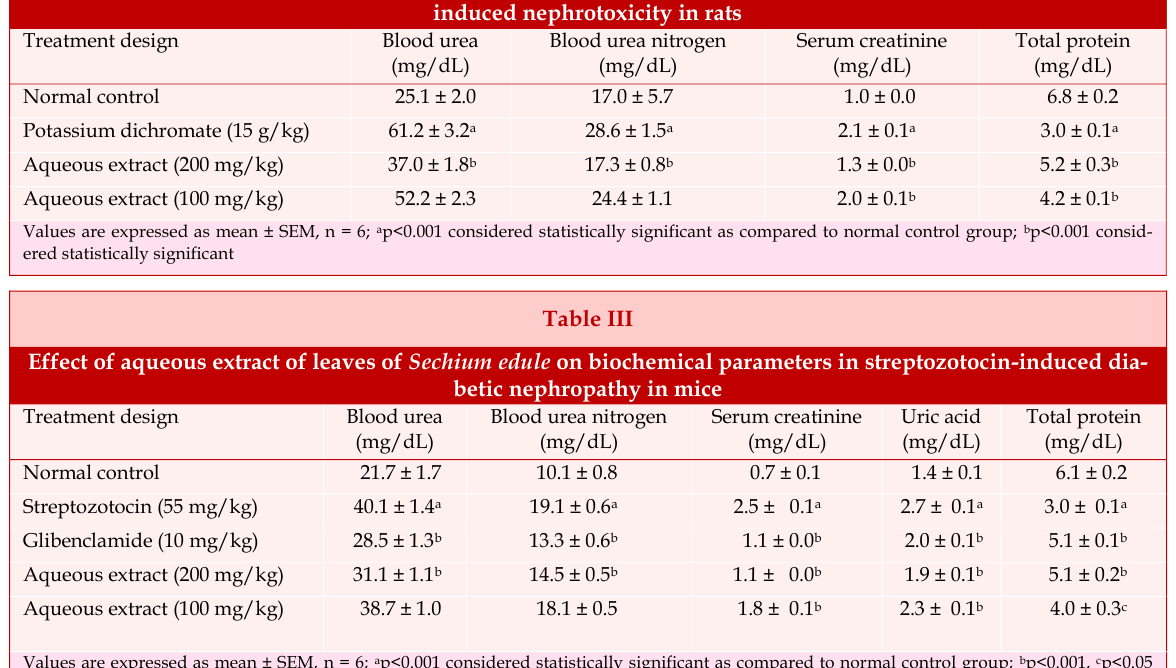
Effect of aqueous extract of leaves of Sechium edule on biochemical parameters in potassium dichromate-